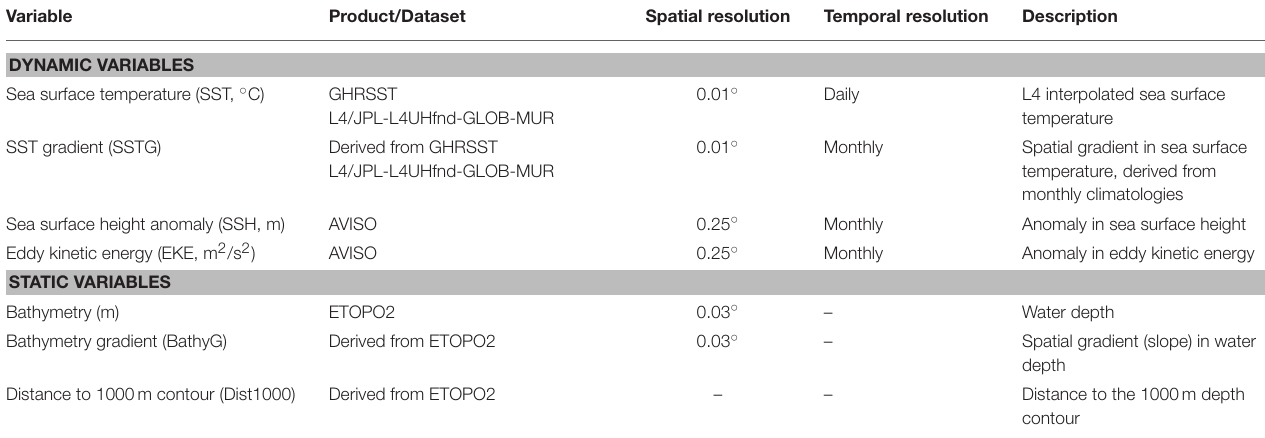
TABLE 1 | List of environmental variables used to model the density of seabirds within the Labrador